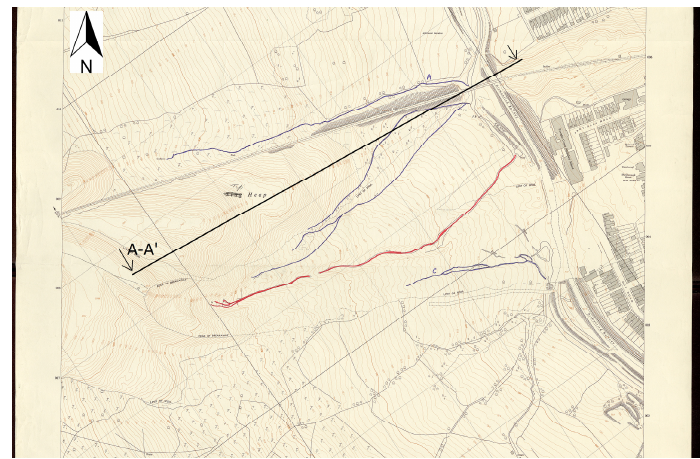
Figure 6. Map of Aberfan after the 1966 flowslide disaster (from UK National Archive).